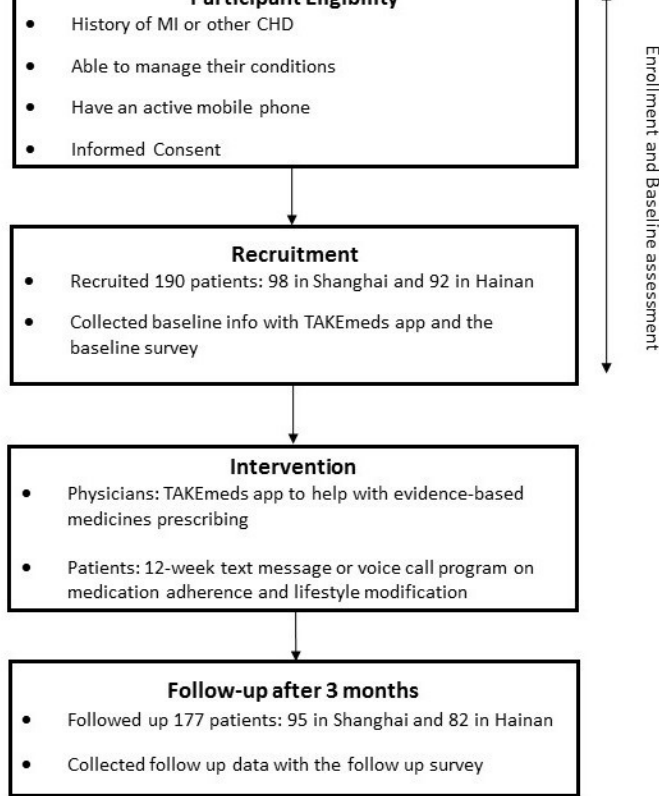
Figure 1. The Adherence and Knowledge Exchange heart disease medicines (TAKEmeds) study